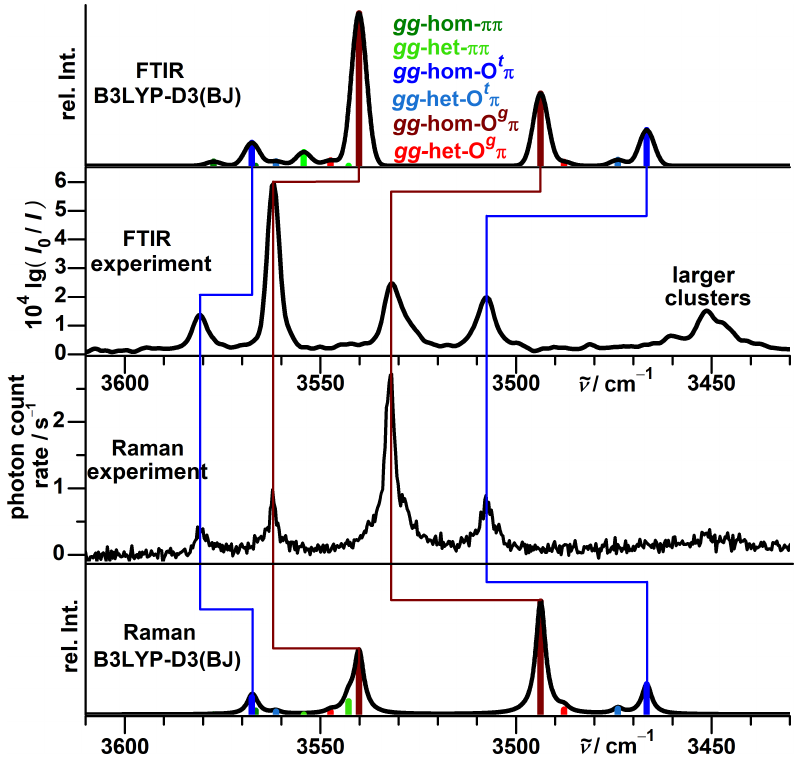
Figure 13. Comparison between experimental (inner) and simulated (outer) FTIR and Raman jet spectra for propargyl alcohol dimers. The simulations assume a conformational temperature of 100 K and identical vibrational and rotational partition functions except for the rotational symmetry number. In addition, the achirality (non-degeneracy) of gg -het- ππ is considered in the statistical weight. Empirically applied are a Gaussian FWHM of 4.5 cm − 1 for the FTIR simulation and a Lorentzian FWHM of 3 cm − 1 for the Raman simulation. Harmonic OH stretching wavenumbers are shifted by − 156 cm − 1 as needed to match the g monomer spectral center of